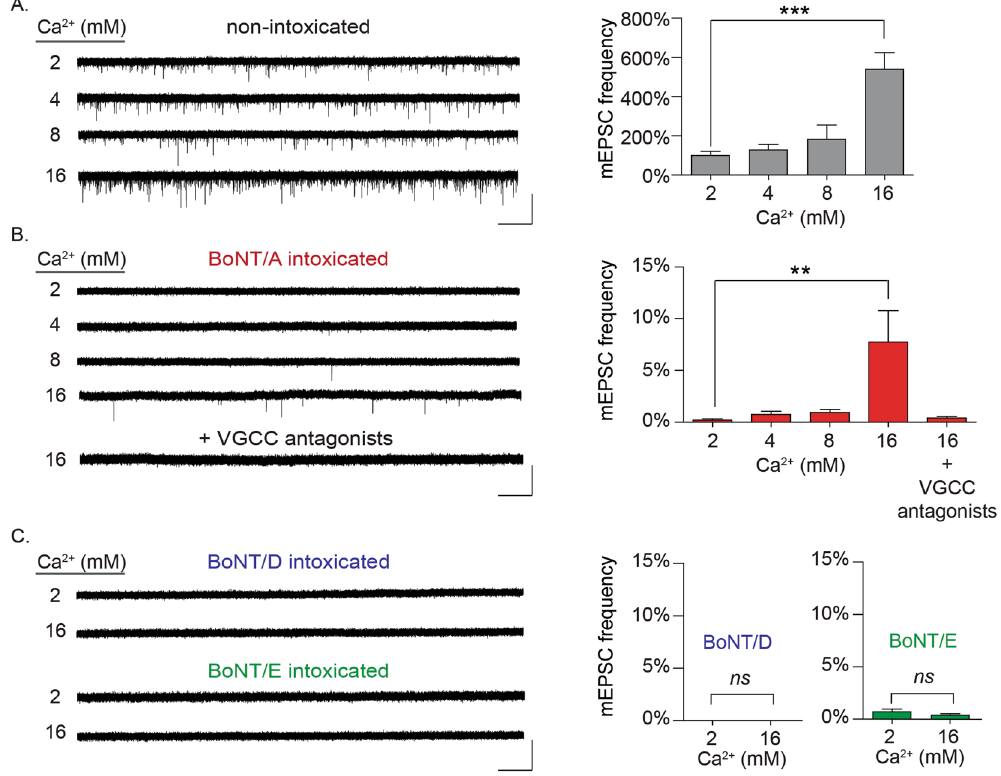
Figure 2. Rescue of spontaneous synaptic activity in BoNT/A-silenced synapses by elevated extracellular Ca 2 + requires VGCCs. ( A ) Representative whole-cell recordings and mean mEPSC frequencies from non- intoxicated cultures in the presence of 2, 4, 8, or 16 mM Ca 2 + . Representative whole-cell recordings and mean mEPSC frequencies from BoNT/A-intoxicated cultures, in the presence of 2, 4, 8, or 16 mM Ca 2 + as well in 16 mM Ca 2 + with VGCC antagonists (10 µ M nimodipine, 0.5 µ M ω -agatoxin IVA and 0.5 µ M ω